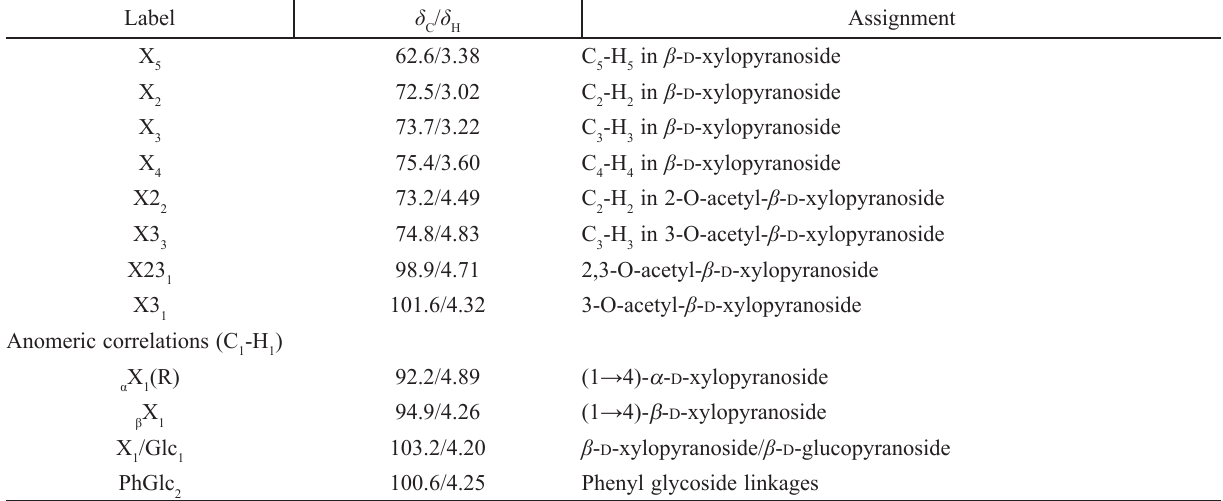
Table S3 – Assignments of the associated carbohydrate 13 C- 1 H cross-signals in 2D H NMRSQc spectra of lignin